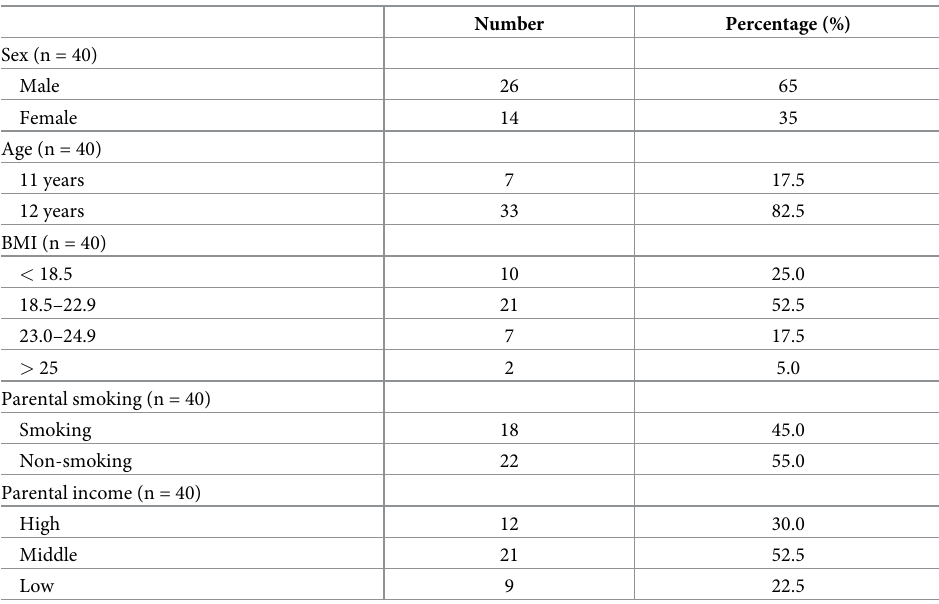
Table 3. The characteristics of participants.